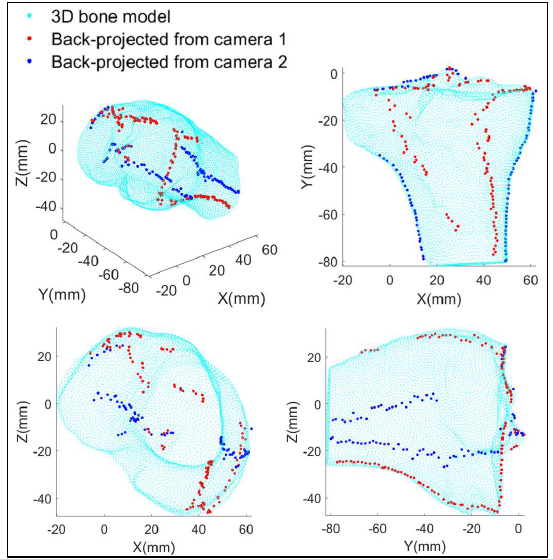
Figure 7. Back-projected edge points onto the 3D bone model of the tibia from a select image pair. 2.2.5